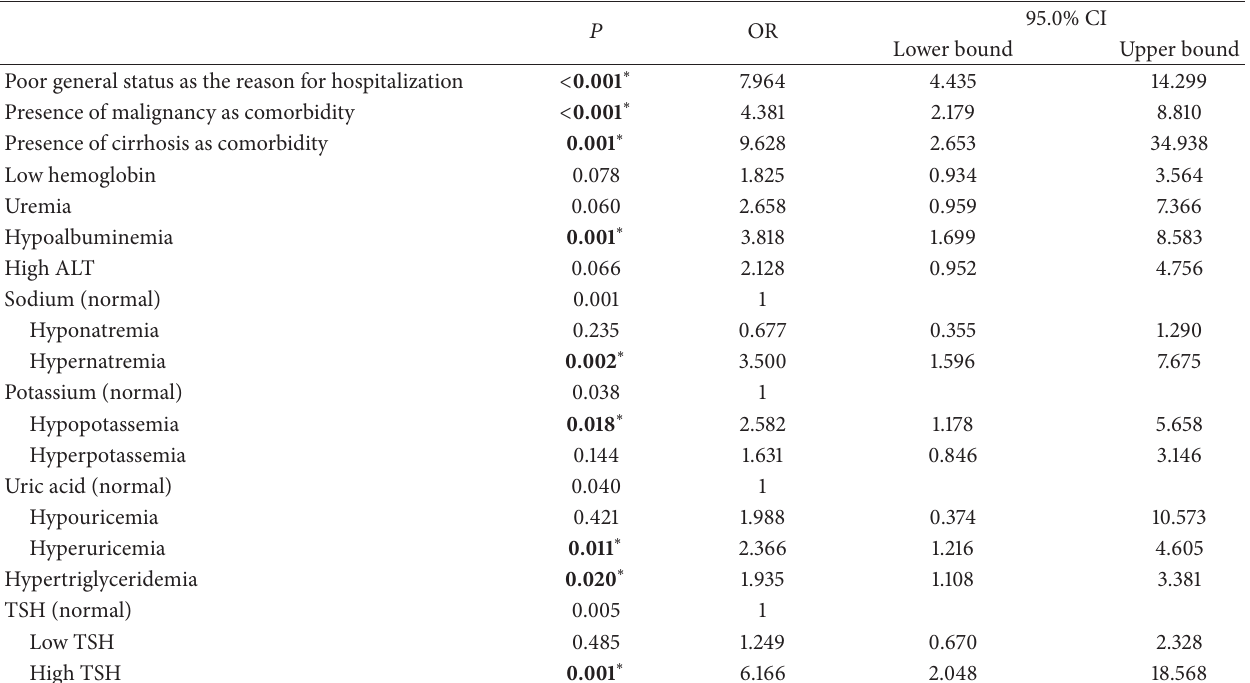
Table 5: Risk factor analysis for